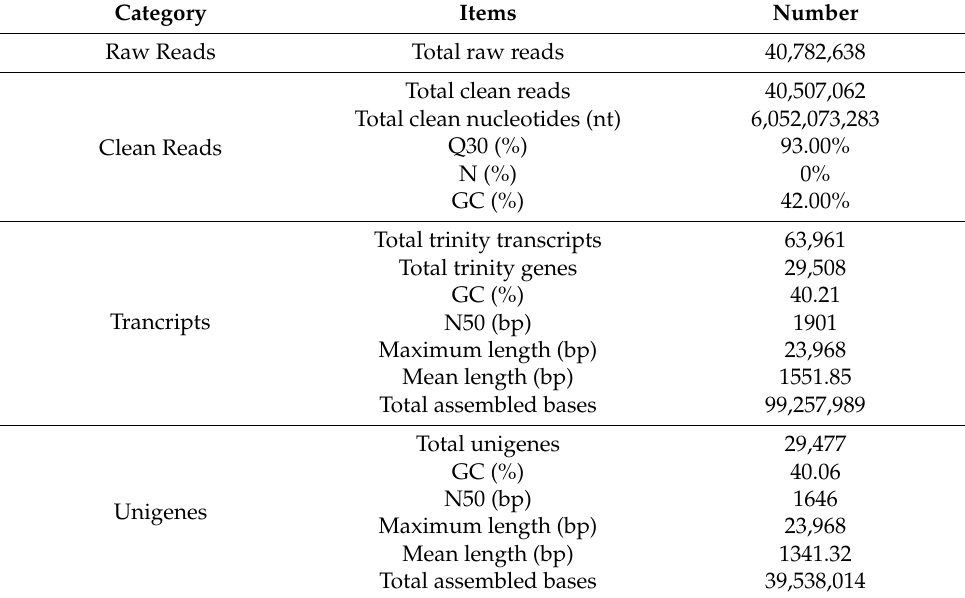
Table 2. Summary of the de novo assembly of C. macrophyllum